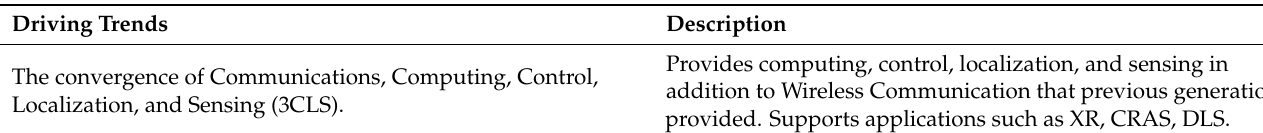
Table 6. A summary of the driving trends towards 6G wireless networks.